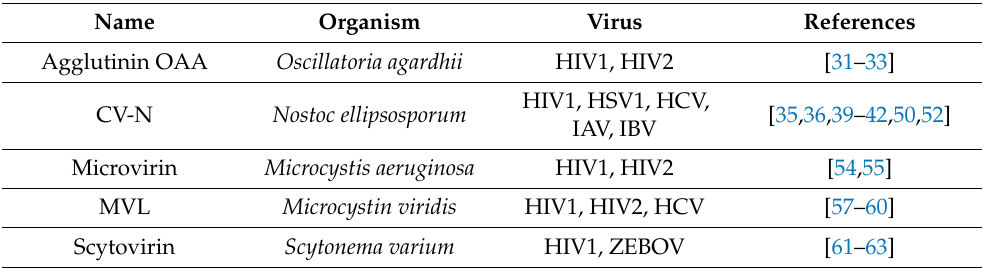
Table 1. Microalgae lectins with antiviral effects. Lectins Interact Directly with the High-Glycan Structure of Viral Envelope